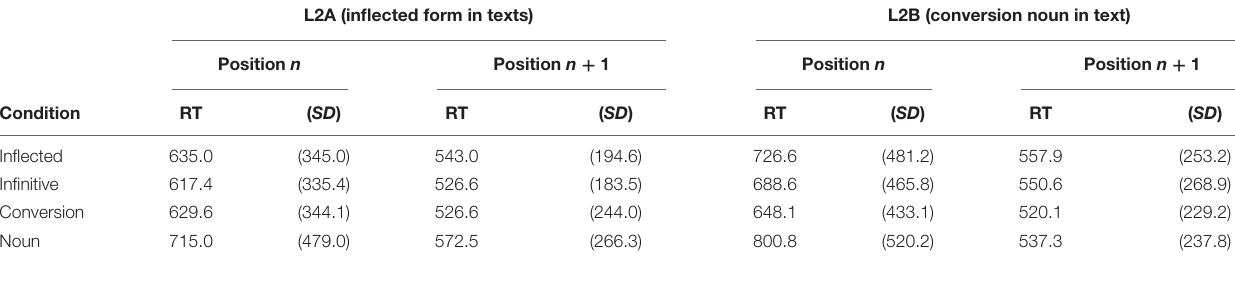
TABLE 6 | Results of Experiments L2A and L2B (mean RTs in ms and SDs).